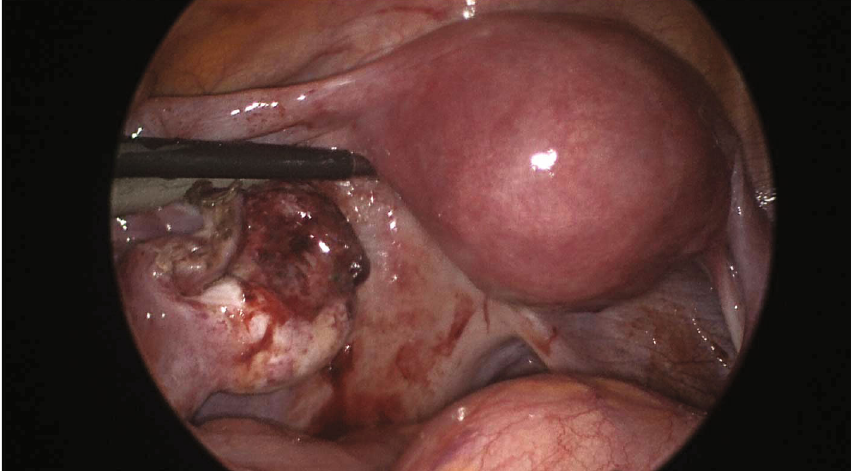
Figure 5: Postresection ipsilateral una ff ected